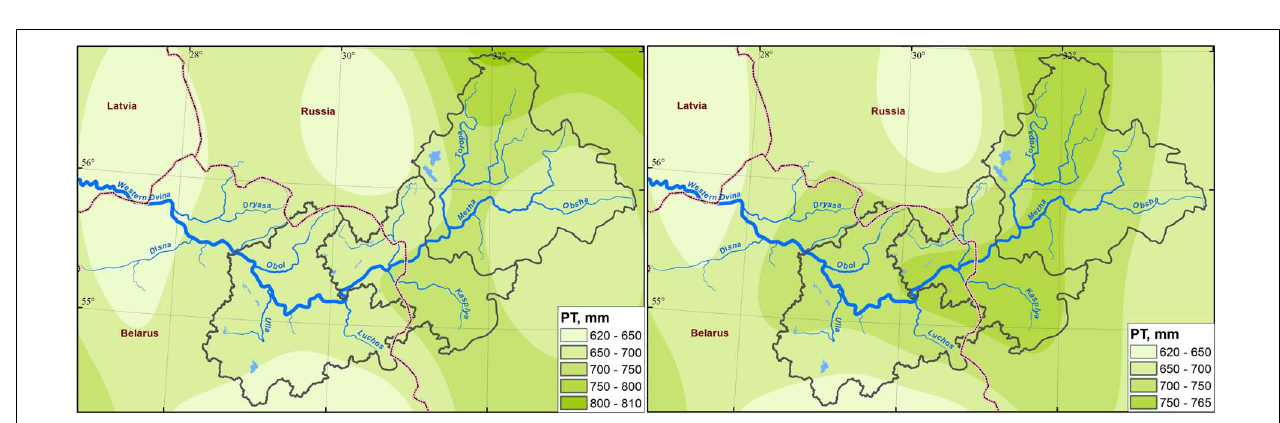
FIGURE 6 | The spatial distribution of annual precipitation totals over the Western Dvina River Basin for two different periods: 1945–2015 (left) and 1989–2015 (right) .